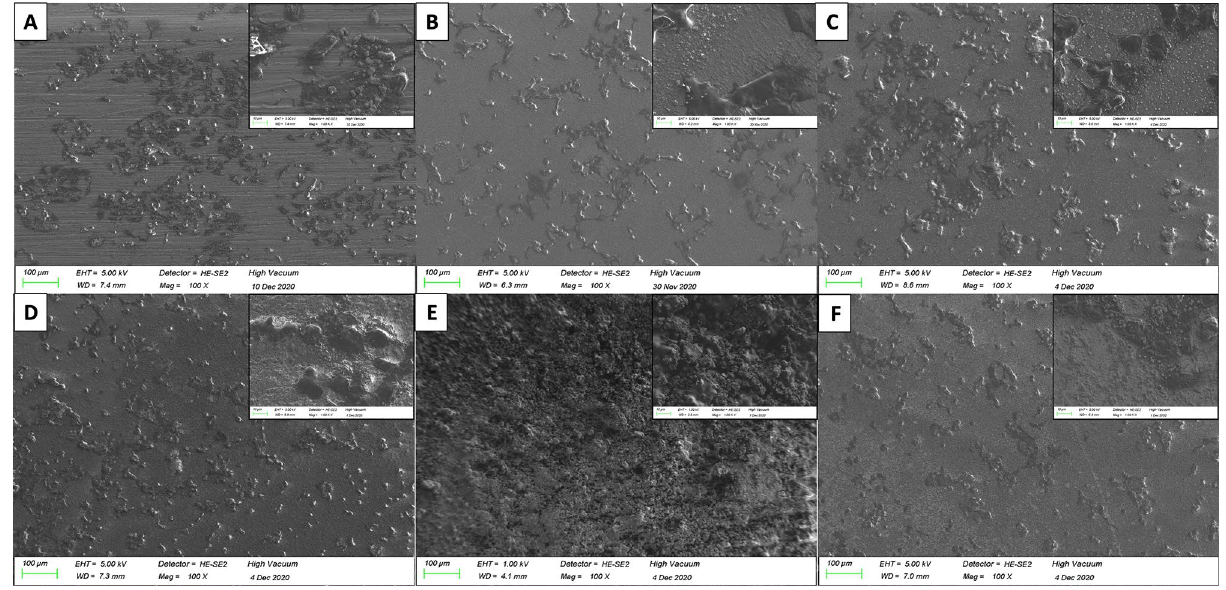
Figure 7. Scanning electron microscope (SEM) images with two different magnifications (100 × and 1000x) of the discs’ surfaces after 24 h of incubation with osteoblastic cell line MG-63; ( A ) non-modified control; ( B ) Samples with phosphate-doped TiO 2 -nanotubes (pTNT) seem to have more viable osteoblastic cells compared to the control; ( C ) selenium-incorporation (SepTNT) leads to a significant increase in cell density and agglomerations; ( D ) hydroxyapatite-coating (HA) on pTNT showed a more of osteoblastic cells but less agglomerations; ( E ) selenium pTNT in combination with HA showed singular osteoblastic cell formation but it appeared that less agglomeration was detected; ( F ) Ag 2 SepTNT showed less osteoblastic cell growth compared with